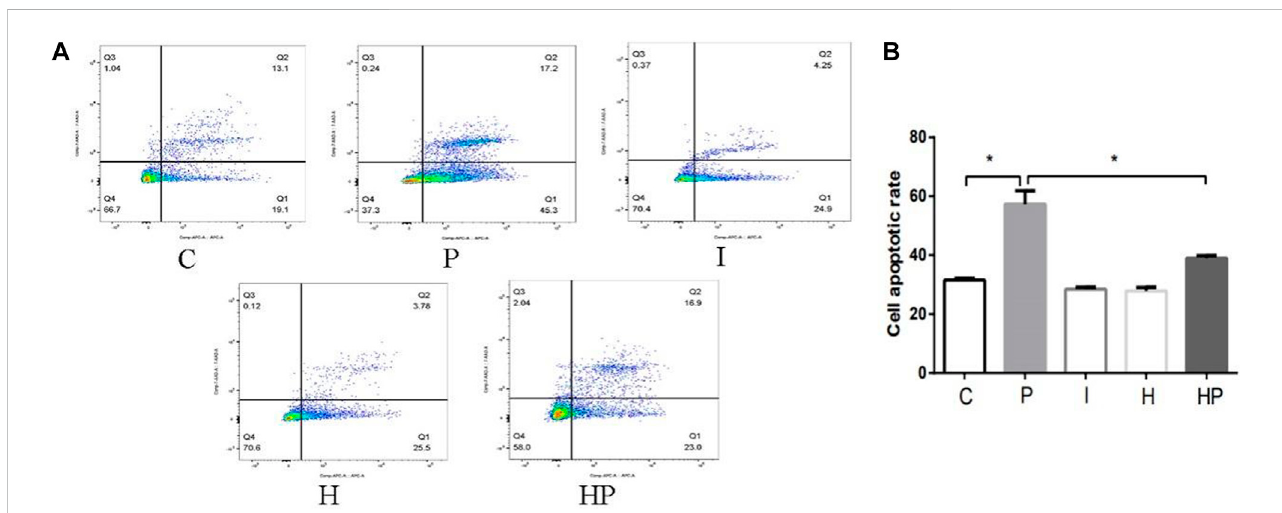
FIGURE 3 Changes in cell apoptosis in primary hippocampal neurons exposed to propofol with or without hypoxic preconditioning. (A,B) Cell apoptosis in each group (one-way ANOVA, * p < 0.05).